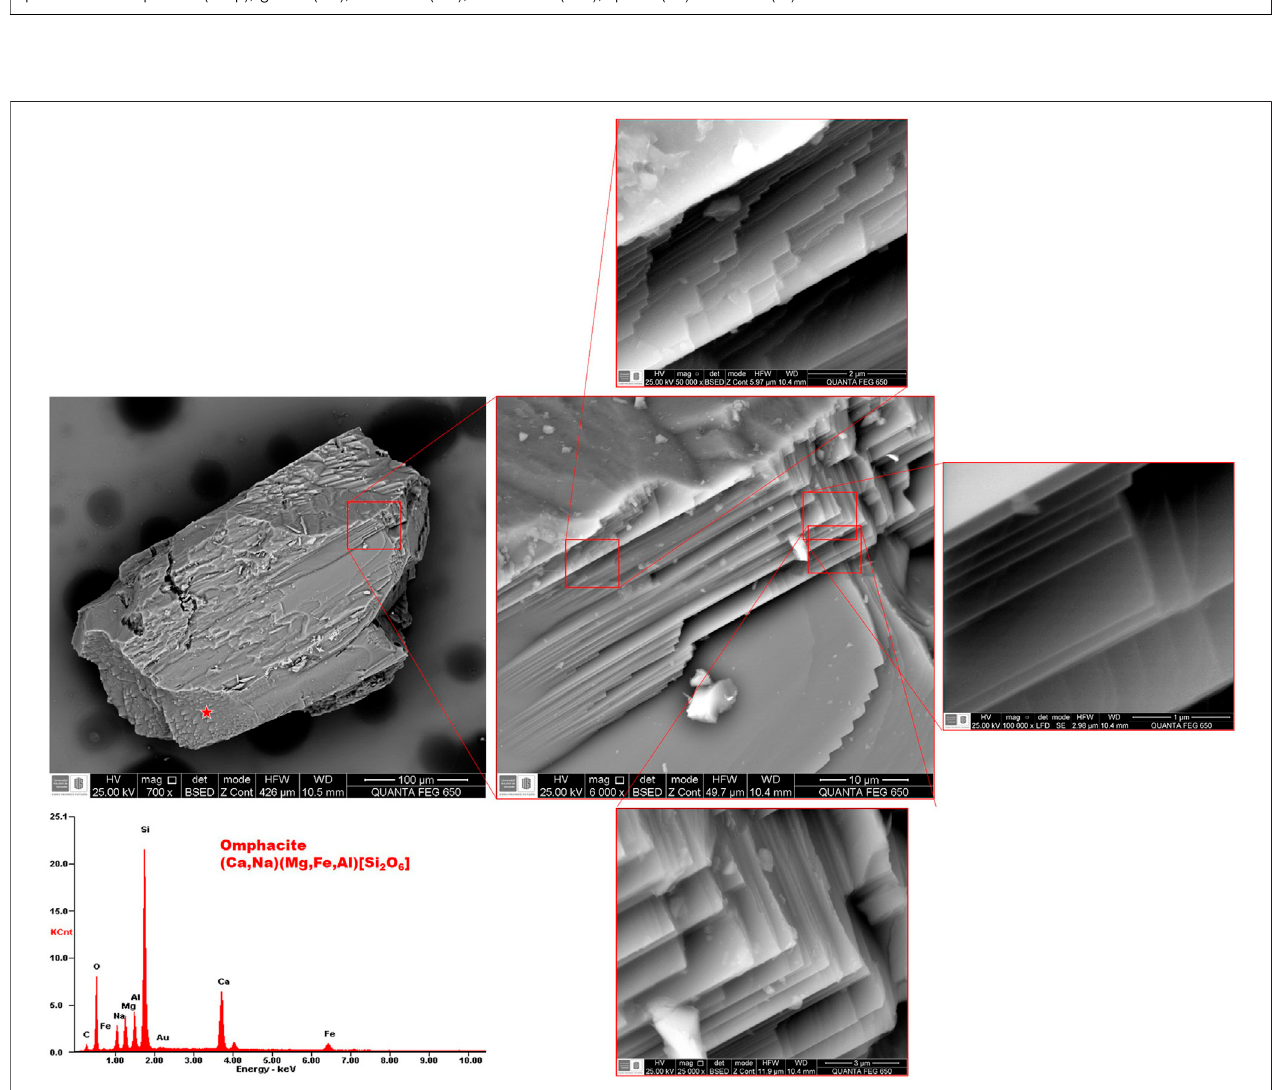
FIGURE 3 | SEM images in BSE mode along with the EDS spectrum of the studied omphacite.